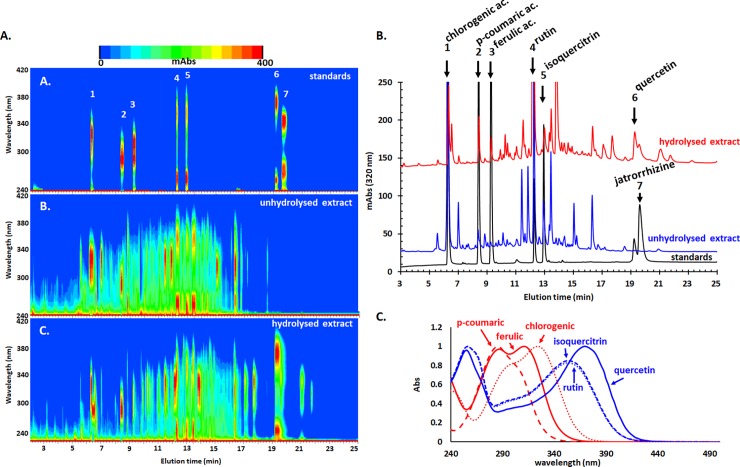
HPLC-UV-vis analysis of the unhydrolysed and hydrolysed G verum extract.(A) Heatmap of the chromatographic profile versus elution time. (B) Chromatograms of the two extracts and of the standards monitored at 320 nm. (C) UV-vis molecular absorption spectra of six of the employed standards.